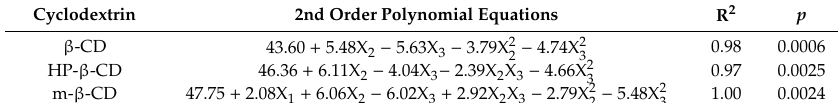
Table 4. Mathematical models and associated statistics derived from the experimental design.